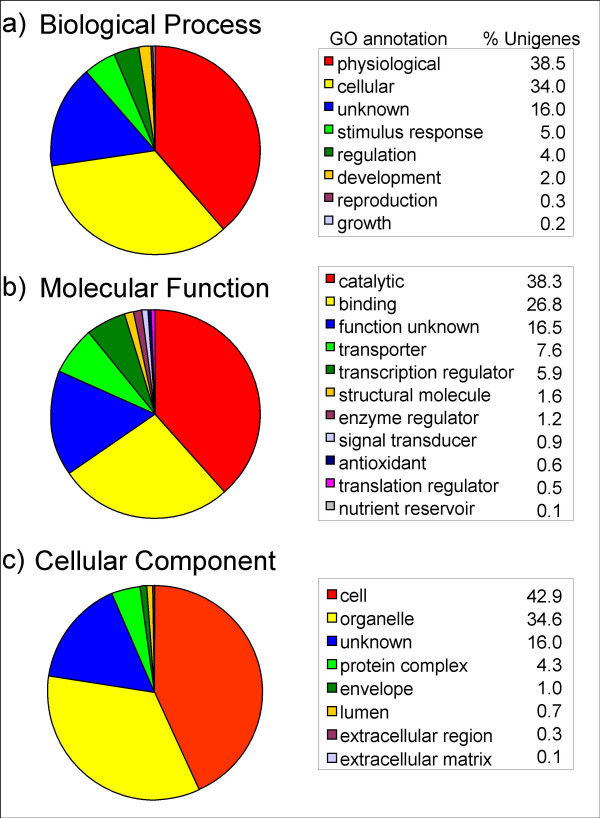
Gene Ontology annotation of Centaurea Unigenes. A normalized cDNA library was created from whole plants representing seven invasive populations of Centaurea maculosa. Five thousand ESTs were sequenced from the 5' end (Agencourt biosciences), and assembled into 4,423 contigs, or 'Centaurea unigenes.' Unigenes were translated in all frames and the resulting amino acid sequences were used as BLAST queries. Top BLAST hits provided annotation and functional categorization (gene ontology assignment) for each Centaurea unigene. Not all unigenes were able to be annotated by GO programs. Computational analysis was done using the PLAN database (Noble Foundation).